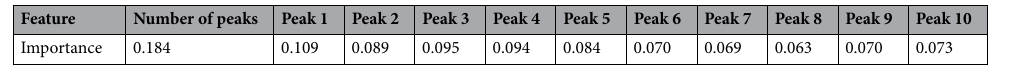
Table 3. Feature importances for crystal system classification. Peak n represents the position of n -th lowest angle